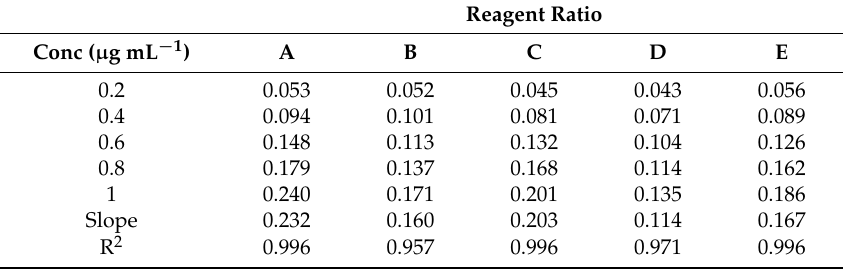
Table 5. Average absorbance of arsenic samples (0.2–1 µ g mL − 1 ) analyzed using various reagent ratios: